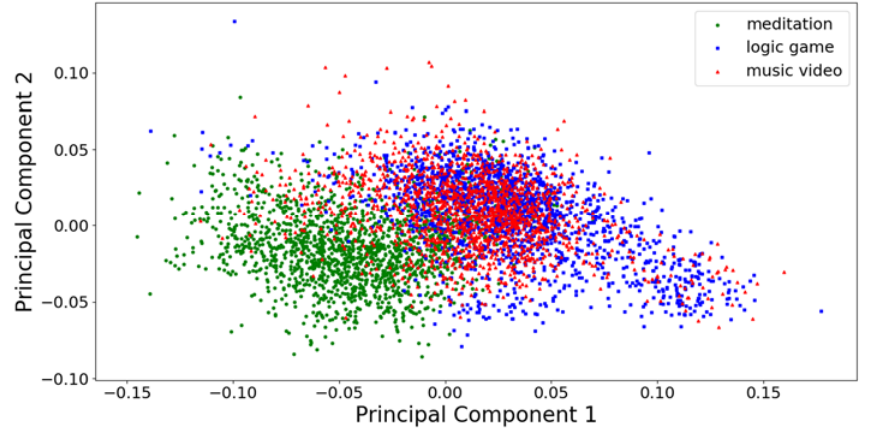
Figure 3. First (x-axis) and second (y-axis) principal component of the test dataset parametrized with Figure 3. First (x ‐ axis) and second (y ‐ axis) principal component of the test dataset parametrized with the welch32 the welch32 scheme.